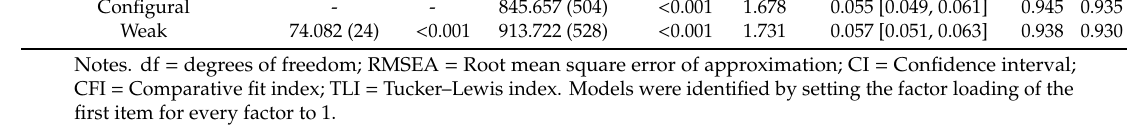
Table 3. Model fit and comparisons of the configural and weak invariant STA-CFA. Implemented